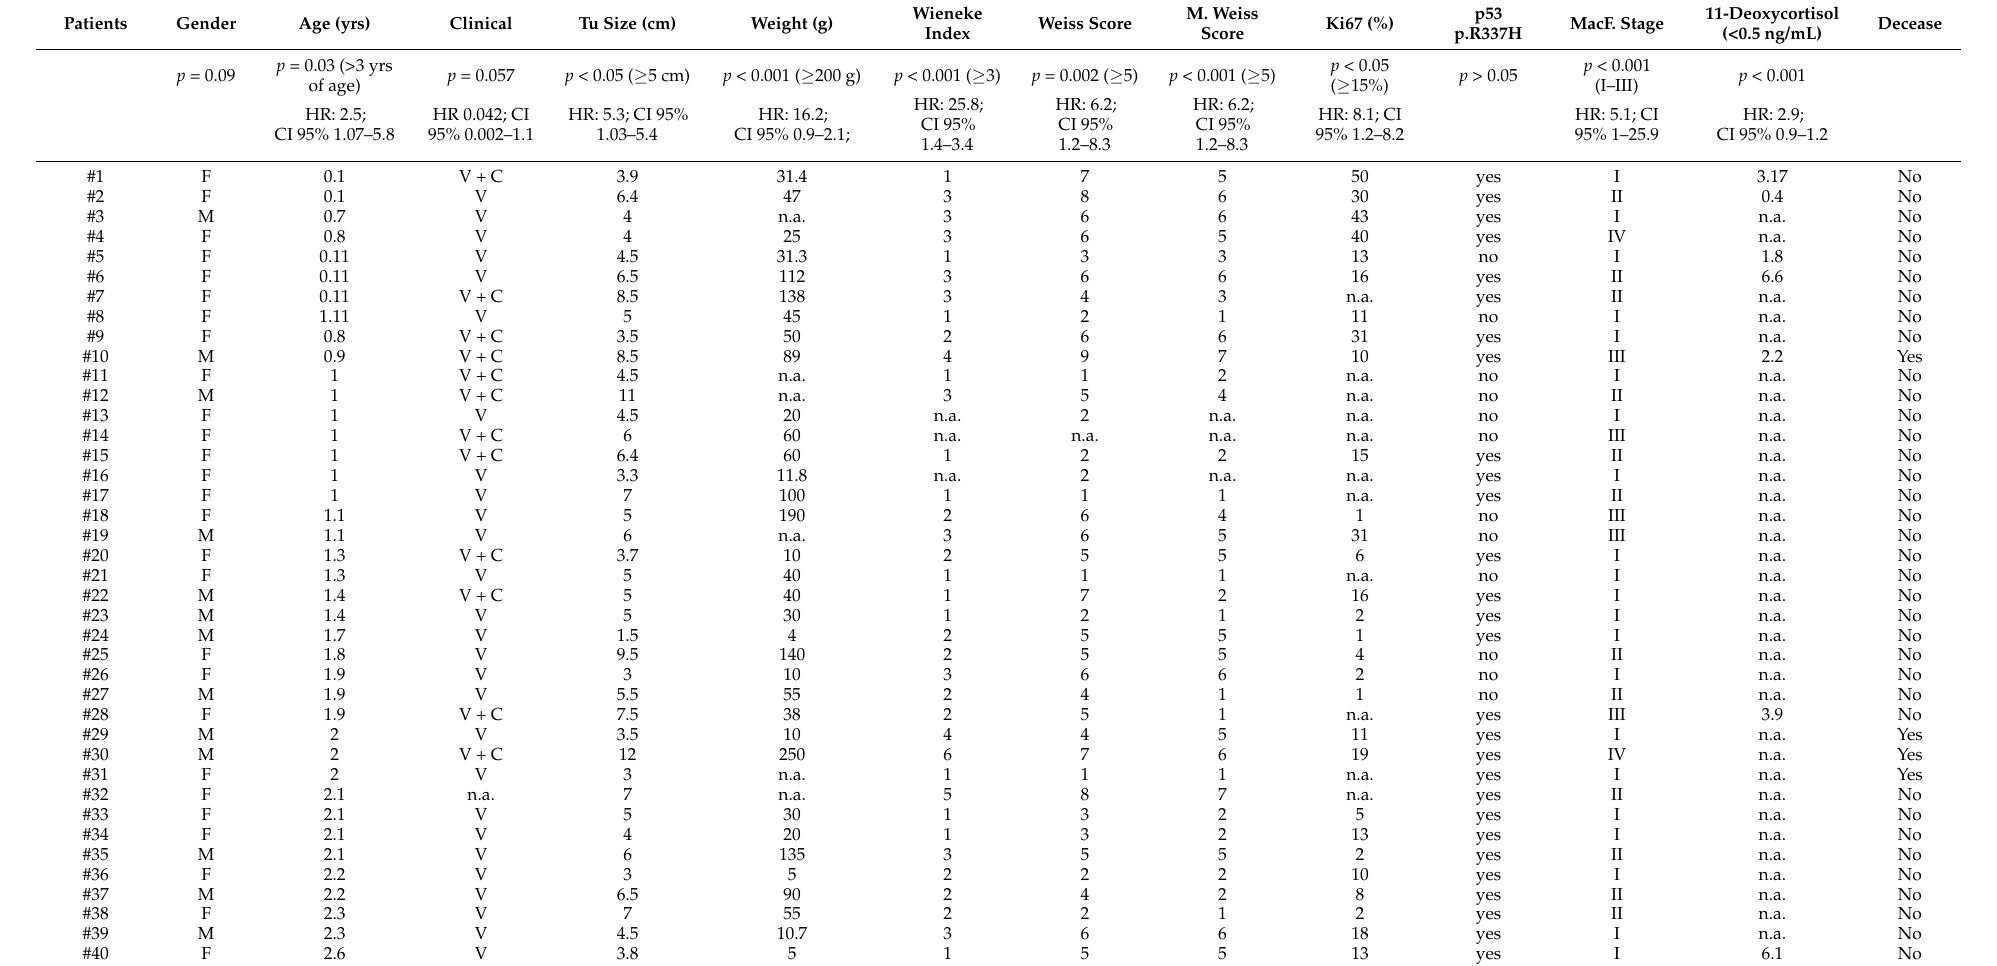
Table 3. Characteristics of patients, initially non-metastatic at diagnosis that developed metastasis during the follow-up (#44; #60; #63; #66; #73; #88; #92),